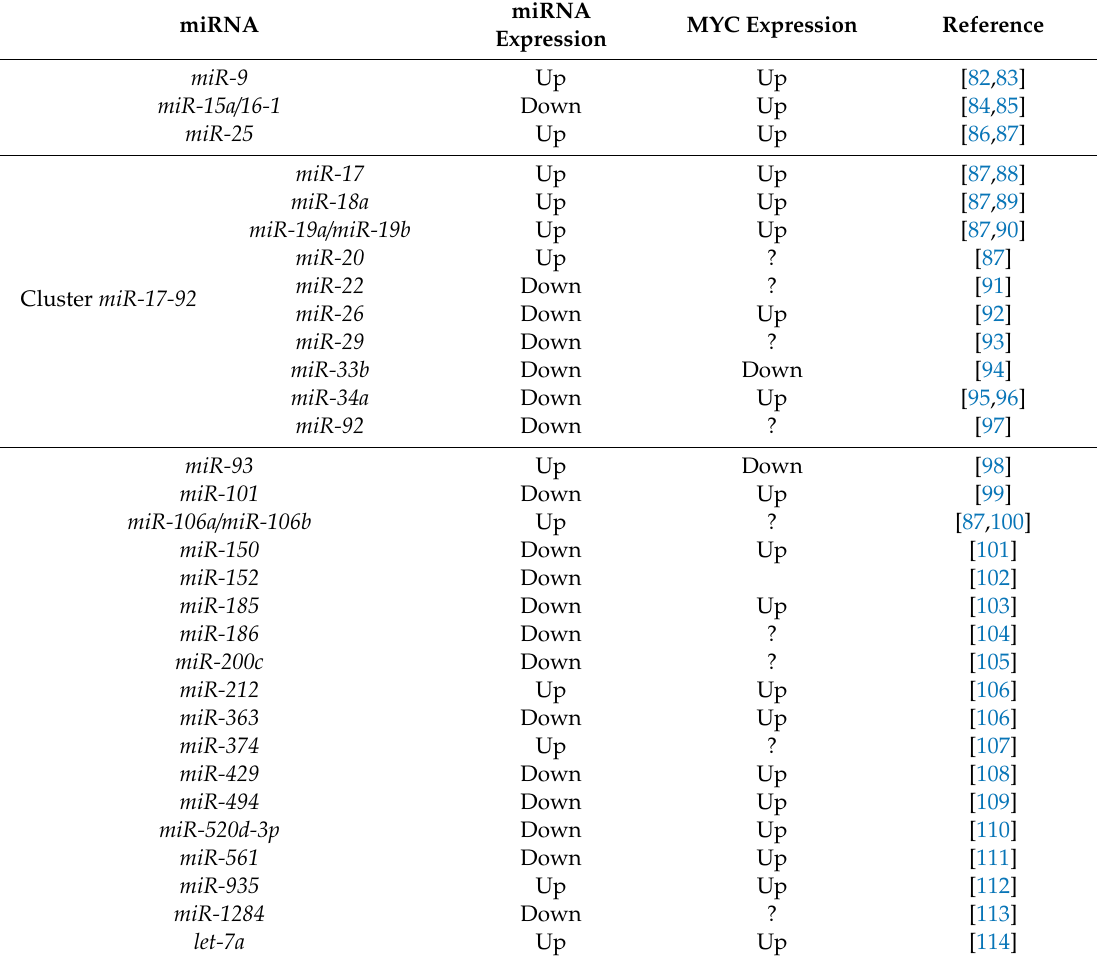
Table 2. Deregulated miRNAs associated directly or indirectly with MYC expression in gastric cancer.